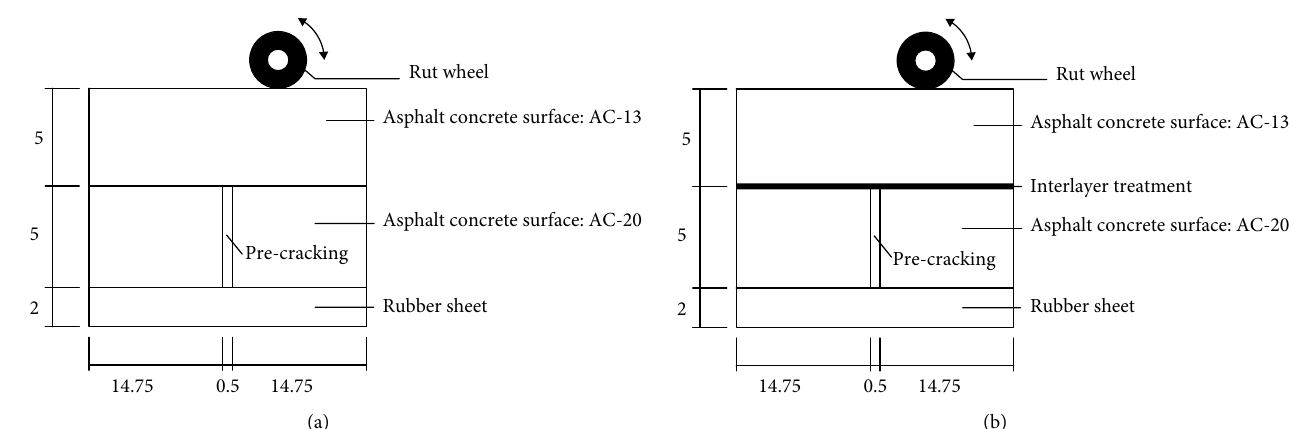
Figure 16: Wheel-load fatigue test model: (a) no interlayer treatment, (b) different interlayer materials and treatment measures.